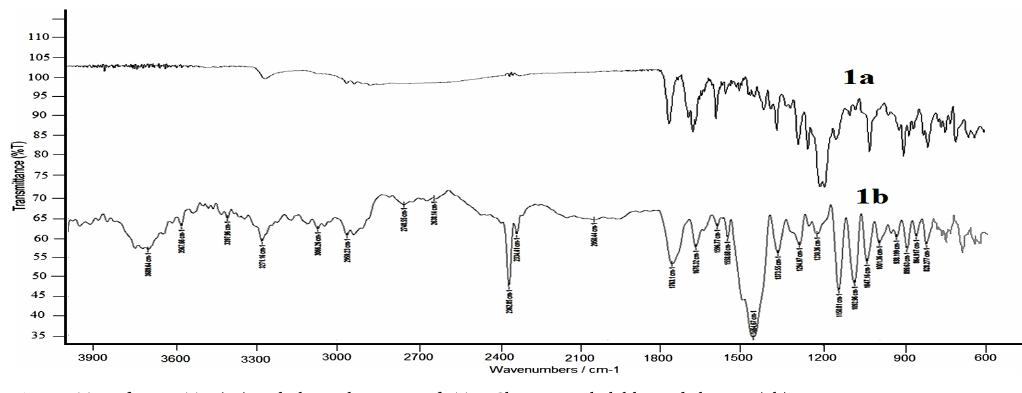
Fig 1. FTIR of pure PTH (1a) and physical mixture of PTH, Chitosan, Inhalable grade lactose